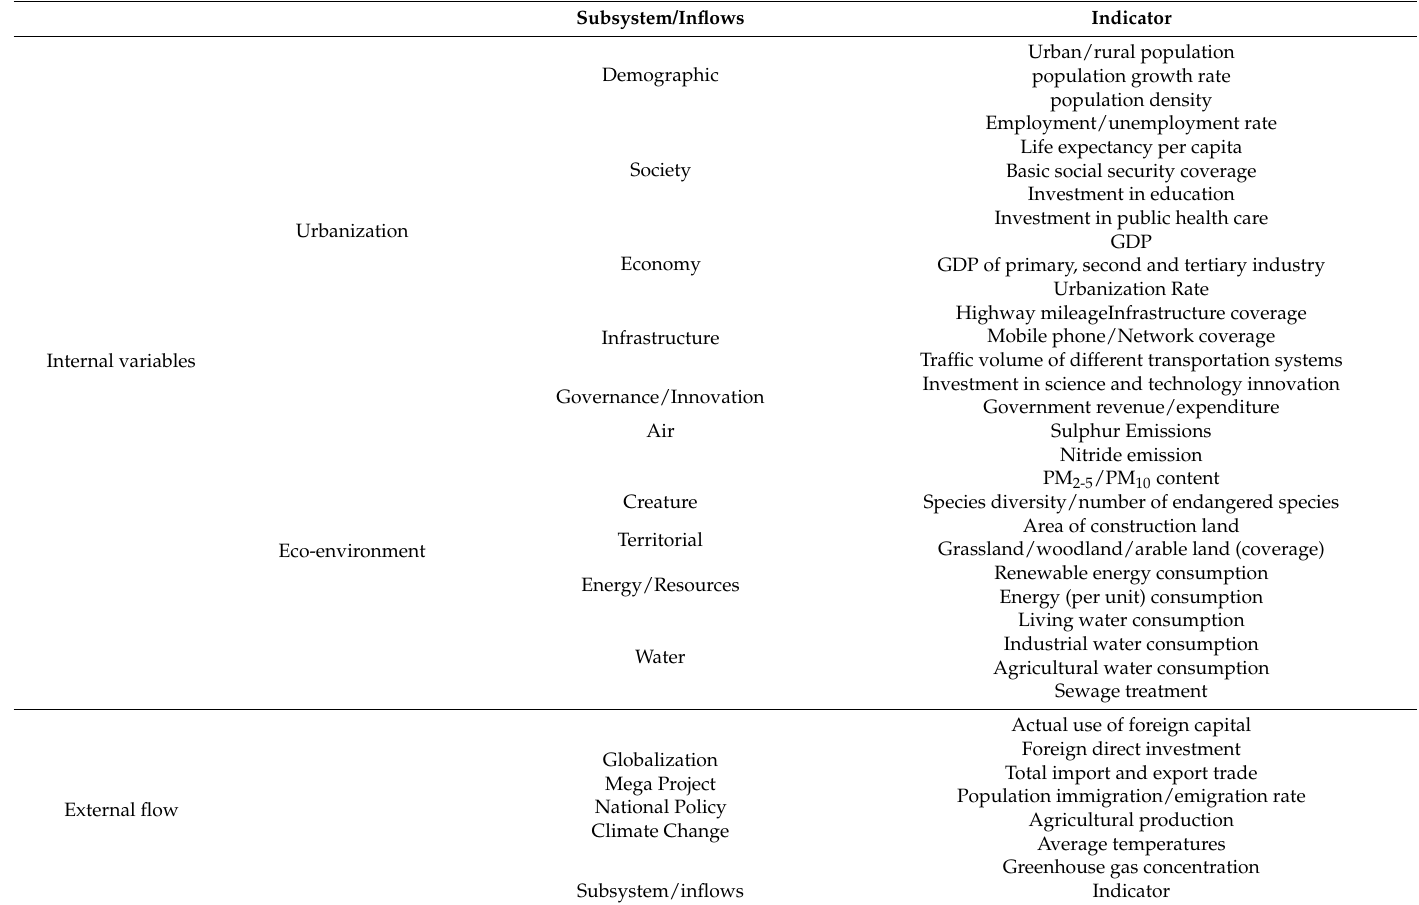
Table 3. Urbanization, eco-environment subsystems and